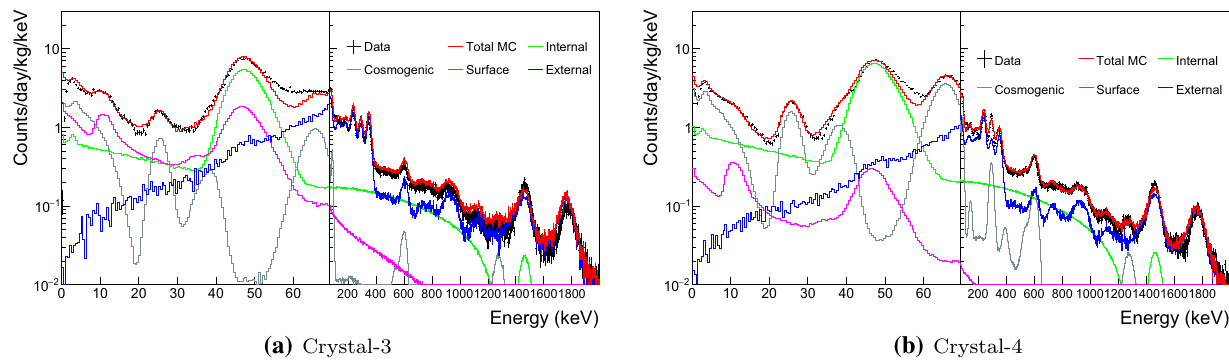
Fig. 4 Measured single-hit background spectra of Crystal-3 and Crystal-4 fitted with all simulated background spectra